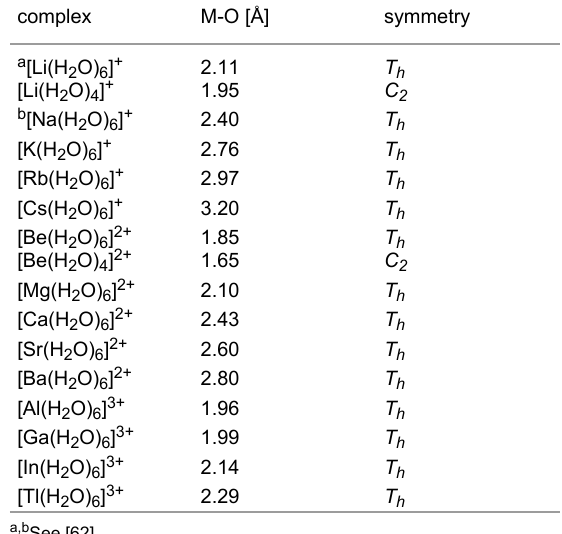
Table 6: Calculated distances (in Å) of the metal–donor interactions in [M(H 2 O) n ] m+